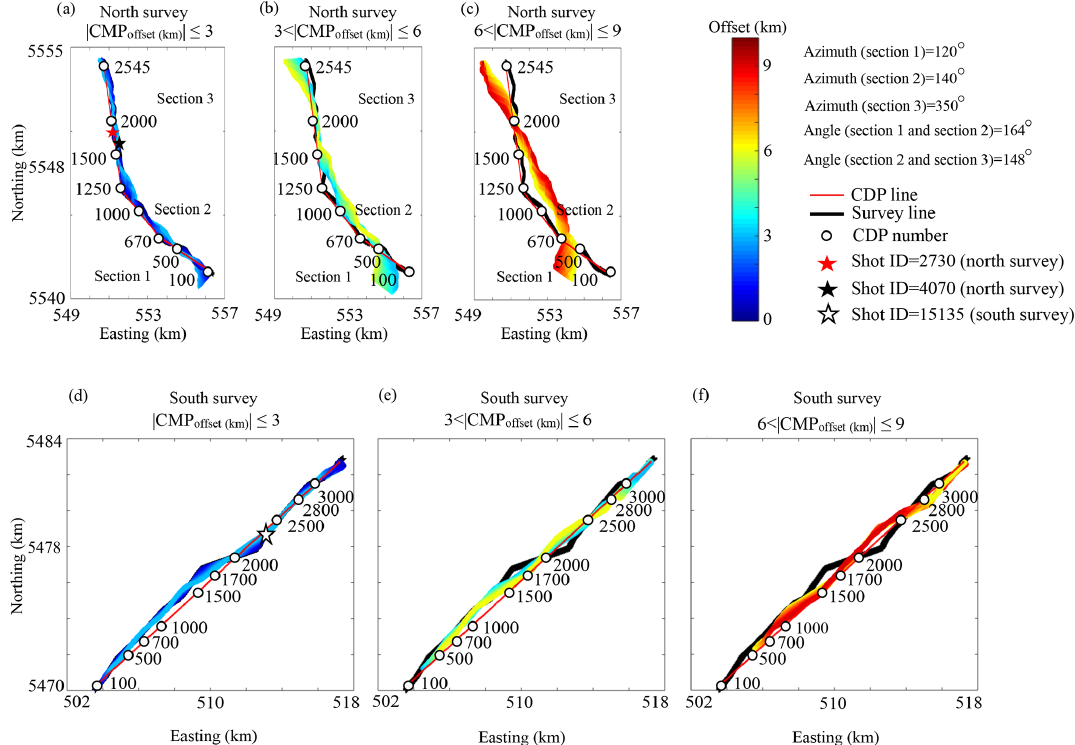
Figure 4. CMP offset distribution at a range of 0–10km for the north and the south survey in the Chibougamau area. The distribution for the north survey is shown for (a) survey it is shown for (d) survey line are shown in the figure. Some shot and CDP locations are also shown. The azimuth of each section of the CDP line from the north survey and the angle between two sequential sections are